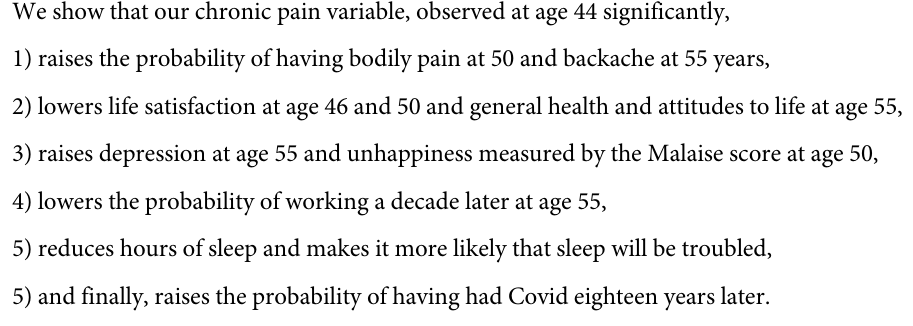
Note : Chronic pain data from BMS, and the characteristics data other than gender from NCDS7 and the PMS,